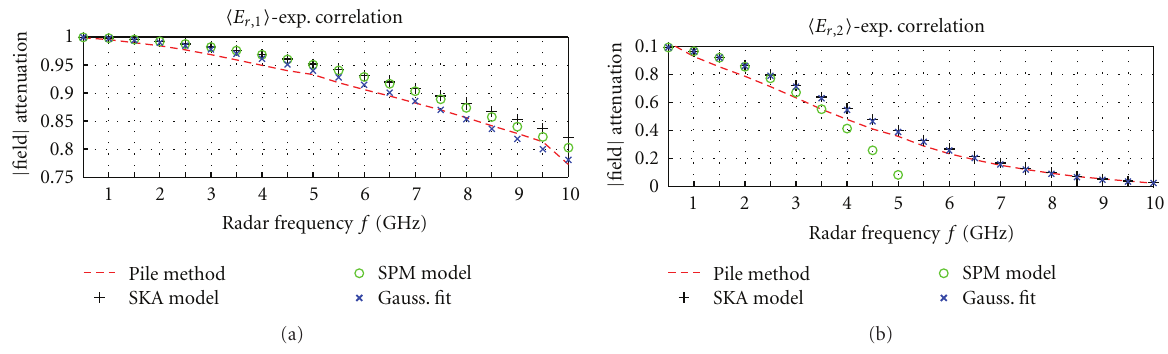
Figure 9: The same simulation parameters as in Figure 8 ( L c A = 6 . 4mm and L c B = 15 . 0mm and σ h A = 1 . 5 mm and σ h B = 3 . 0mm), but for exponential correlation